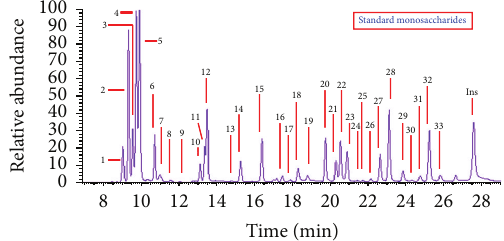
Figure 1: The TIC chromatograph of standard monosaccharide by TMS methyl method. Arabinose (peaks 1, 2, 5, 6, and 8), rhamnose (peaks 3, 4, 7, and 9), xylose (peaks 10–13), mannose (peaks 14–16 and 19), galactose (peaks 17, 18, 20, and 21), glucose (peaks 22, 28, 29, and 32), galacturonic acid (peaks 23–26, 30, and 31), and fucose (peaks 27 and